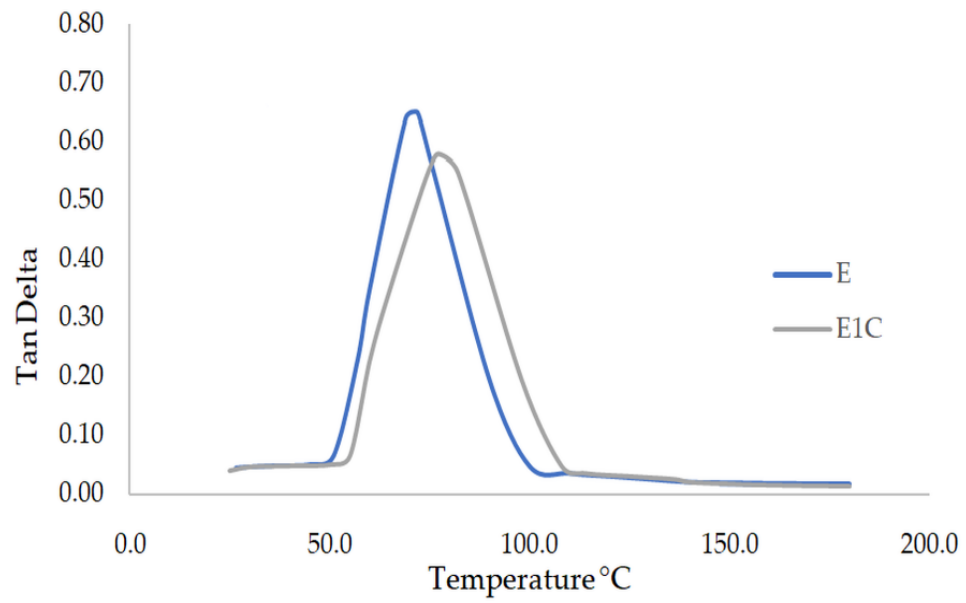
Figure 3. tan delta curve for epoxy nano and multiscale composites.